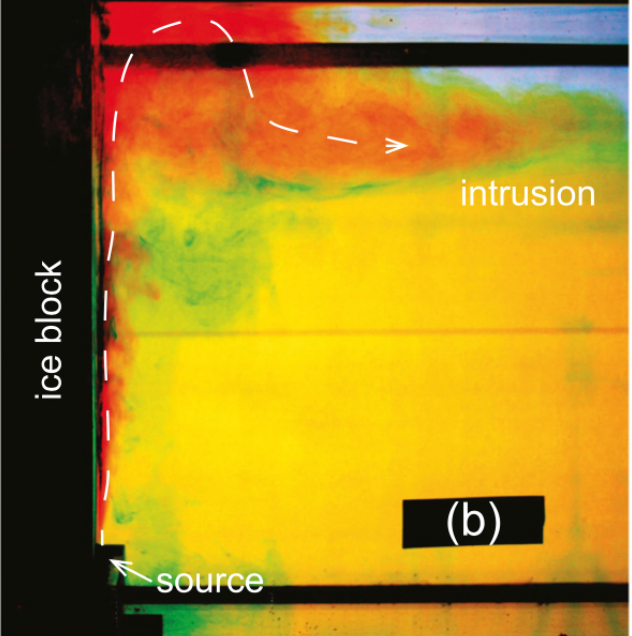
Figure 6. Side view of the experimental setup with an ice block on the left (dyed blue) and a plume released from the bottom (dyed red). Ambient water is dyed yellow, and the green dyed areas indicate regions of mixing between the ambient water and meltwater. Figure 2 (b) reproduced from [128], with permission from the American Meteorological Society,